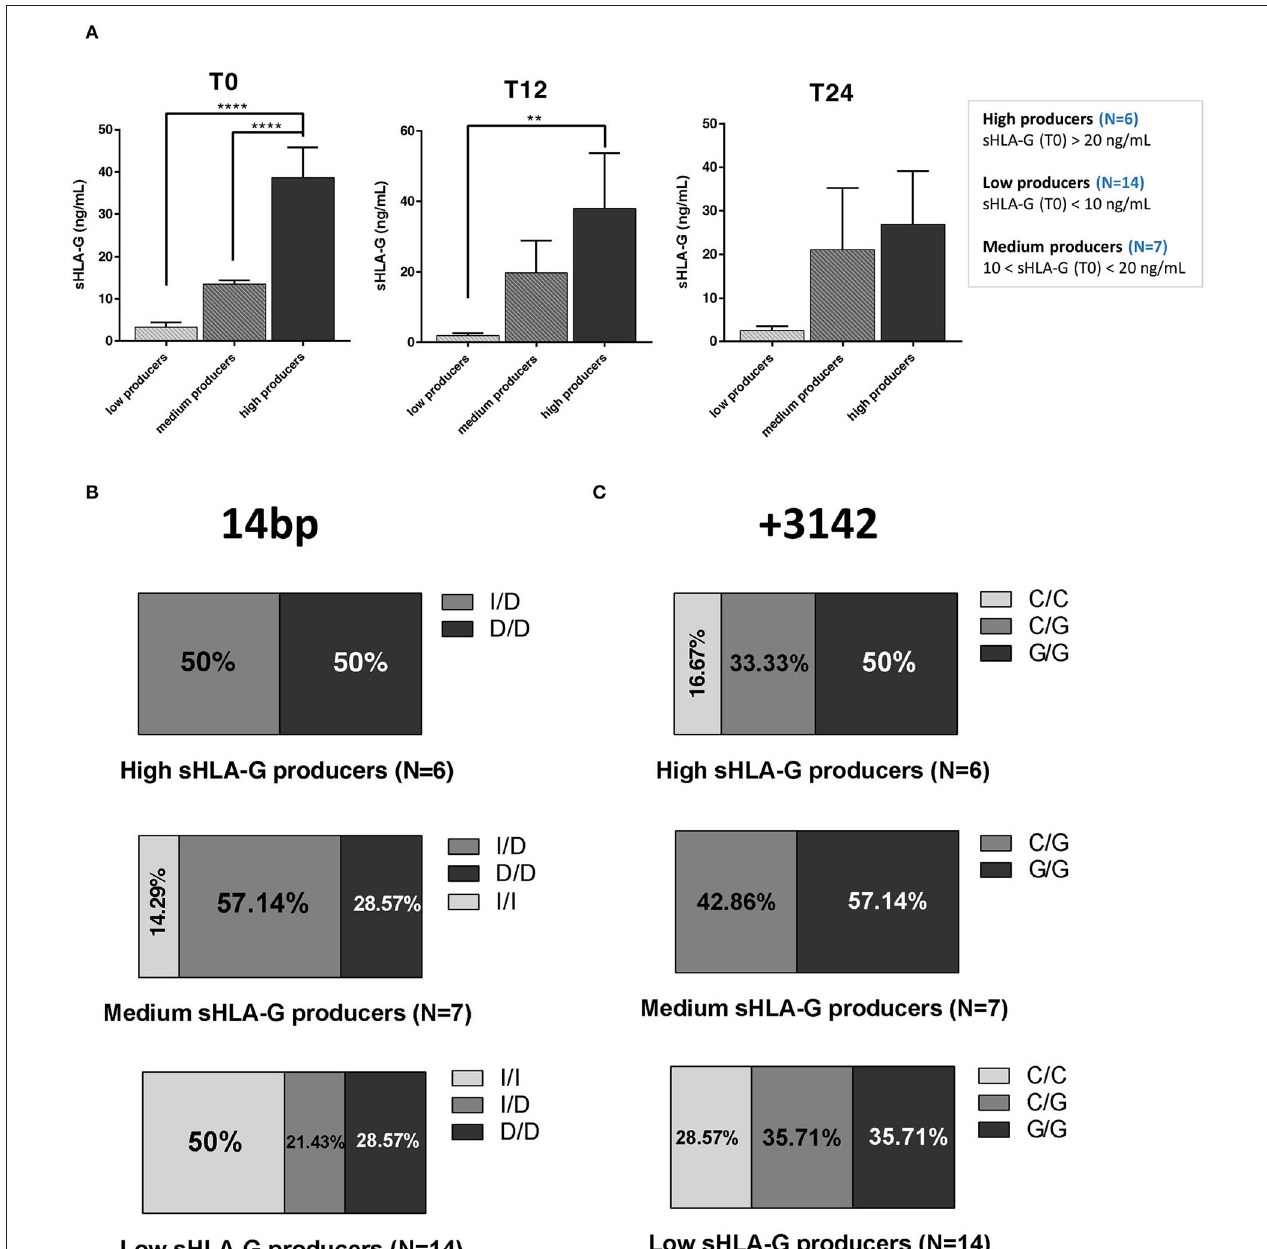
FIGURE 2 | RRMS patients under natalizumab are divided into high, medium, and low sHLA-G producers, who are characterized by different 14 bp and + 3142 genotypes distribution. (A) sHLA-G production (ng/ml) in low, medium, and high producers at baseline (T0; left graph), at T12 (middle graph), and at T24 (right graph) of NTZ treatment. A total of 27 RRMS were divided into 3 groups (14 low producers, 7 medium producers, and 6 high producers) based on serum sHLA-G concentration, as reported in the legend. Mean ± SEM is reported (one-way ANOVA followed by post-hoc Tukey’s test; ** p < 0.01; **** p < 0.0001). (B) Percentage of 3 different genotypes of the 14 bp polymorphism of the HLA-G gene in high, medium, and low sHLA-G producers within the RRMS cohort: insertion/insertion (I/I), insertion/deletion (I/D), and deletion/deletion (D/D). (C) Percentage of 3 different genotypes of the + 3142 C > G polymorphism (C/C, C/G, and G/G) of the HLA-G gene in high, medium, and low sHLA-G producers within the RRMS cohort. Chi-square test was used.